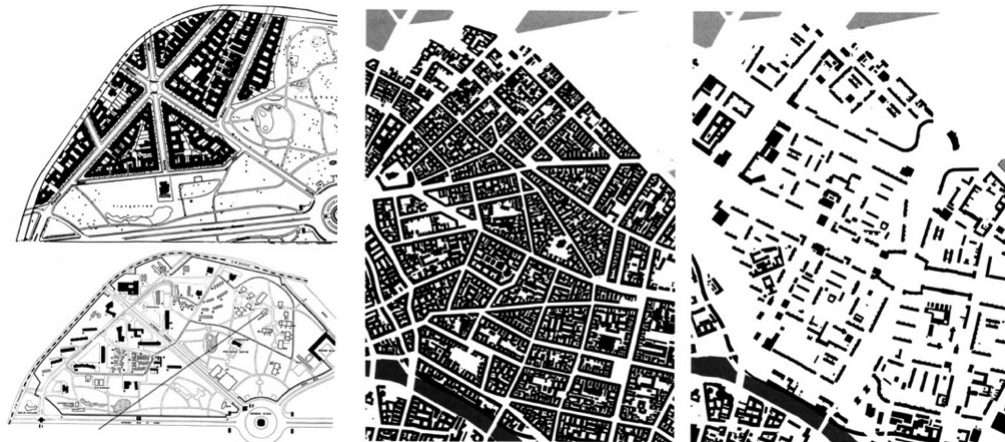
Figure 14. Traditional city versus post-war city: Hansa Viertel and Stalin-Allee (today Karl-Marx-Allee ), Berlin. Source: Stimmann (2002).